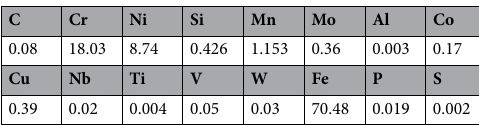
Table 1. Chemical composition of SS304 (wt%).